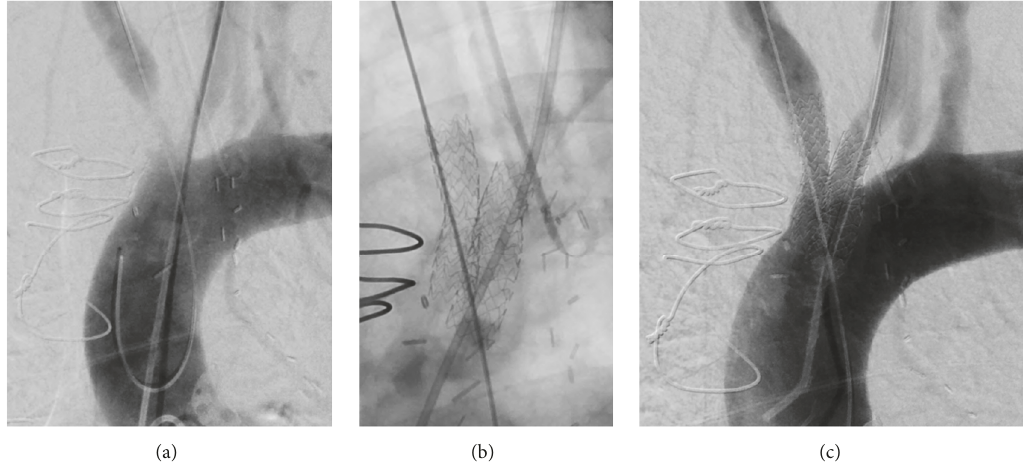
Figure 2: (a) Baseline angiogram of severe stenosis of the innominate and left common carotid arteries. (b) Omnilink stents across both vessels advanced over both wires in the common carotid arteries. (c) Final angiogram after stenting with antegrade flow in both vessels.